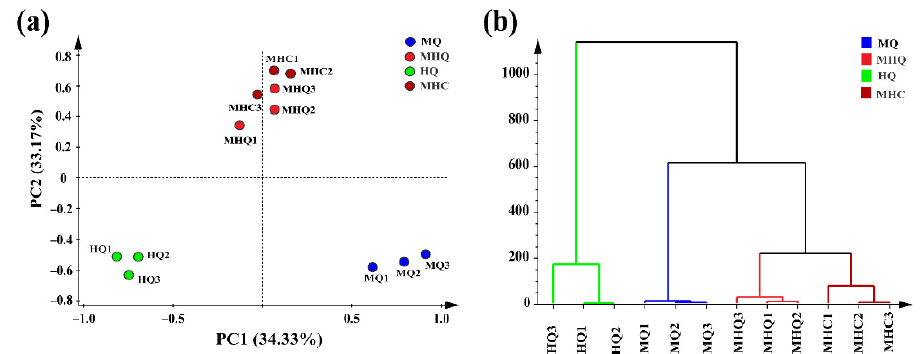
Figure 6. Fungal community structure of different mature Daqu. ( a ) Principal coordinate analysis (PCoA) of the fungal communities based on Bray-Curtis distances. ( b ) Hierarchical clustering analysis (HCA) of fungal communities. Triplicate samples are shown as ‘#1’ to ‘#3’.